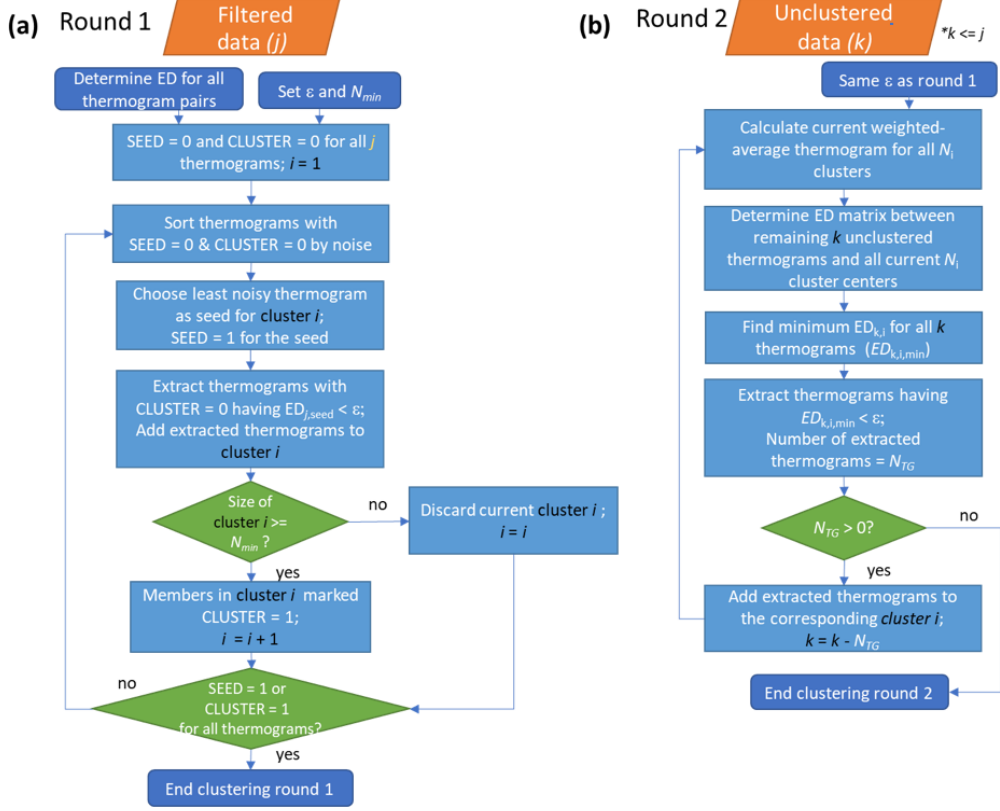
Figure 2. Flow of the noise-sorted scanning clustering. There are two rounds of clustering. (a) Round 1: the EDs between all thermogram pairs are calculated and two parameters, ε and N min , are set. Each thermogram is initialized with state SEED = 0 and CLUSTER = 0. Only thermograms with SEED = 0 and CLUSTER = 0 can serve as seeds, while thermograms with CLUSTER = 0 can be added to new clusters. The procedure terminates when all the thermograms are marked either SEED = 1 or CLUSTER = 1. (b) Round 2: seeds are specified as the weighted average thermogram for each cluster, and any remaining unclustered thermograms from Round 1 are potentially added to these clusters. With the indexing, j refers to the total number of thermograms, i to the number of clusters, and k to the number of unclustered thermograms after Round